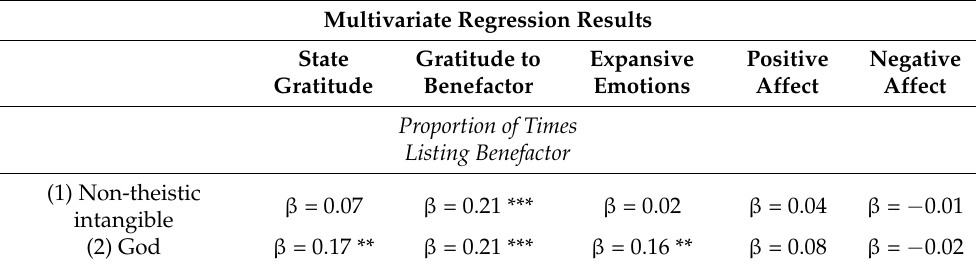
Table 4. Hypothesis 3 and 4: Attitude accessibility predicting